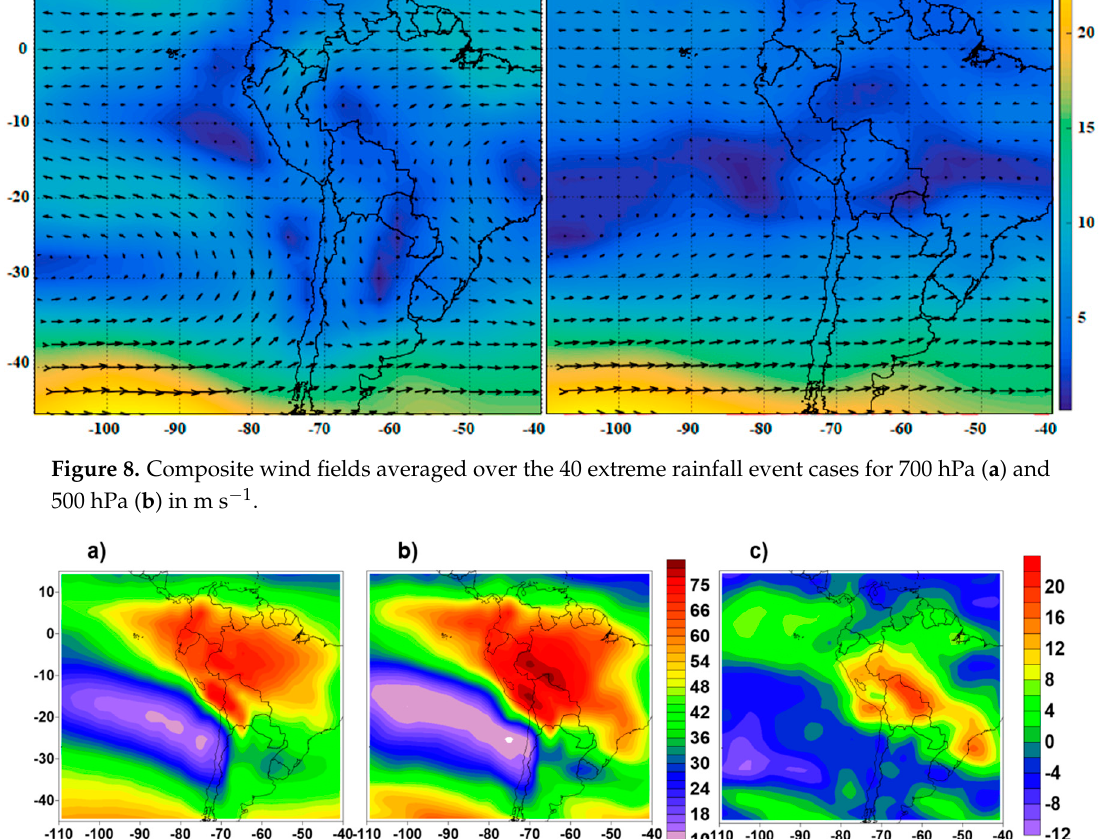
Figure 9. 500–700 hPa layer relative humidity averaged over the rainy seasons of 1981–2017 ( a ); the 40 extreme rainfall event cases ( b ) and their difference ( c ) to highlight deviations from the rainy season climatology.